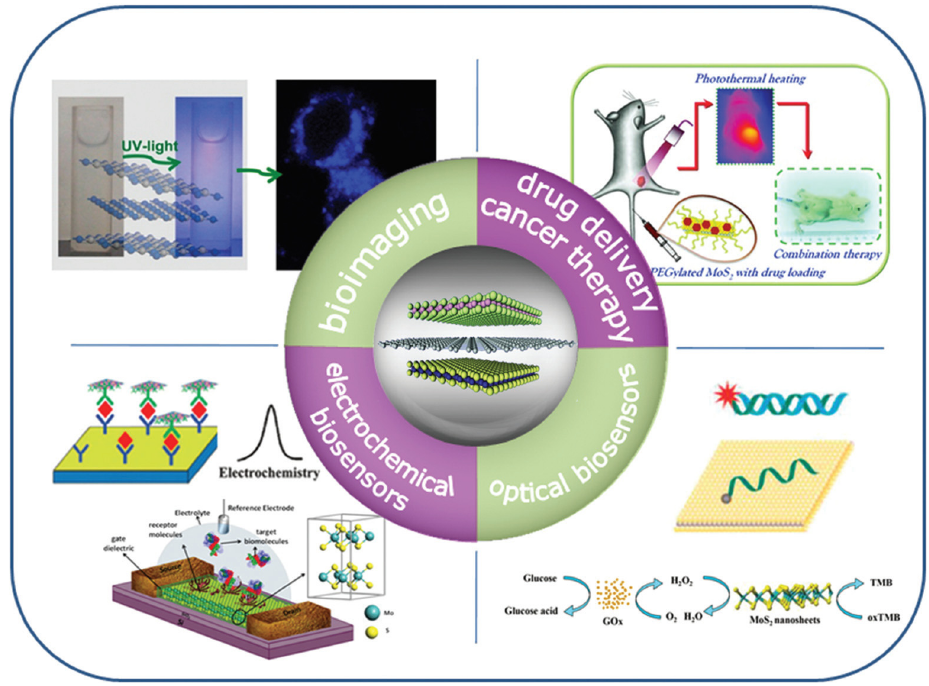
Figure 2. Possible applications of 2D-based nanomaterials [16].